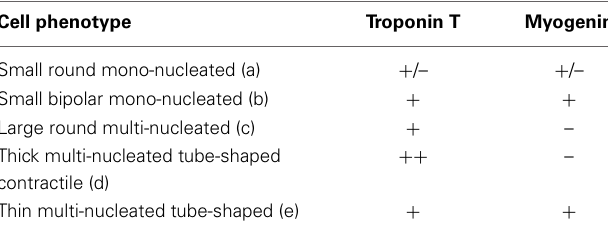
Table 2 | Combinations of cardiac and skeletal myogenic protein expression associated with distinct cell morphologies in cardiomyogenic